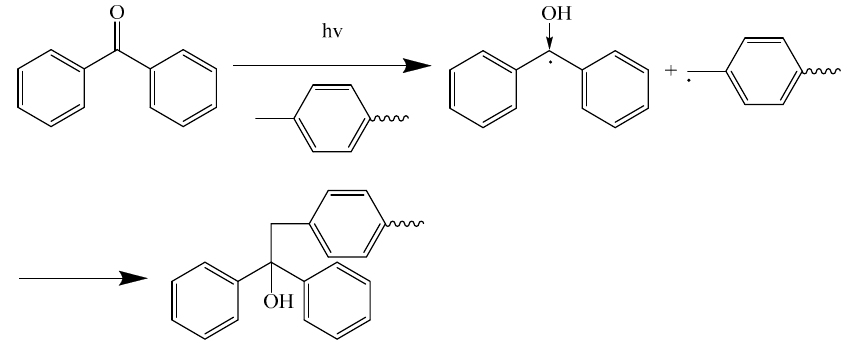
Figure 21. The reaction mechanism of UV crosslinking-modified polyimide containing BTDA.